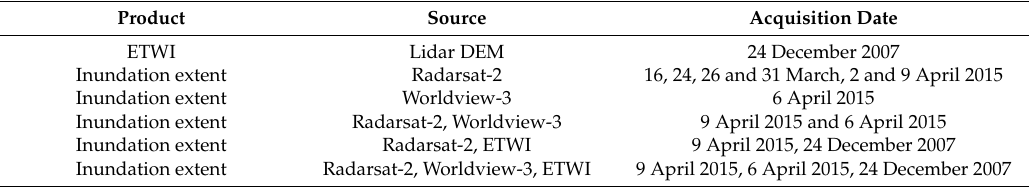
Table 1. Cont. Table 1. Products used in the analysis, their sources and date of acquisition. Lidar: light detection and ranging. DEM: Digital elevation model. ETWI: enhanced topographic wetness